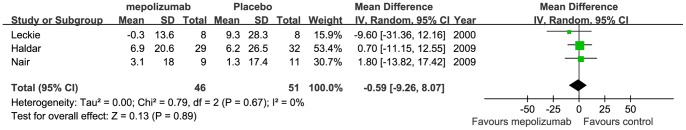
The effects of mepolizumab on FEV1% of predicted value.